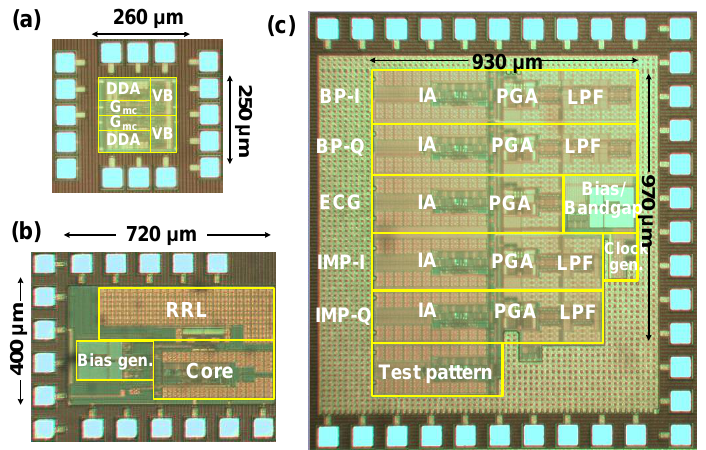
Figure 17. Microphotograph of ( a ) current driver, ( b ) preamplifier, ( c ) back-end signal processing